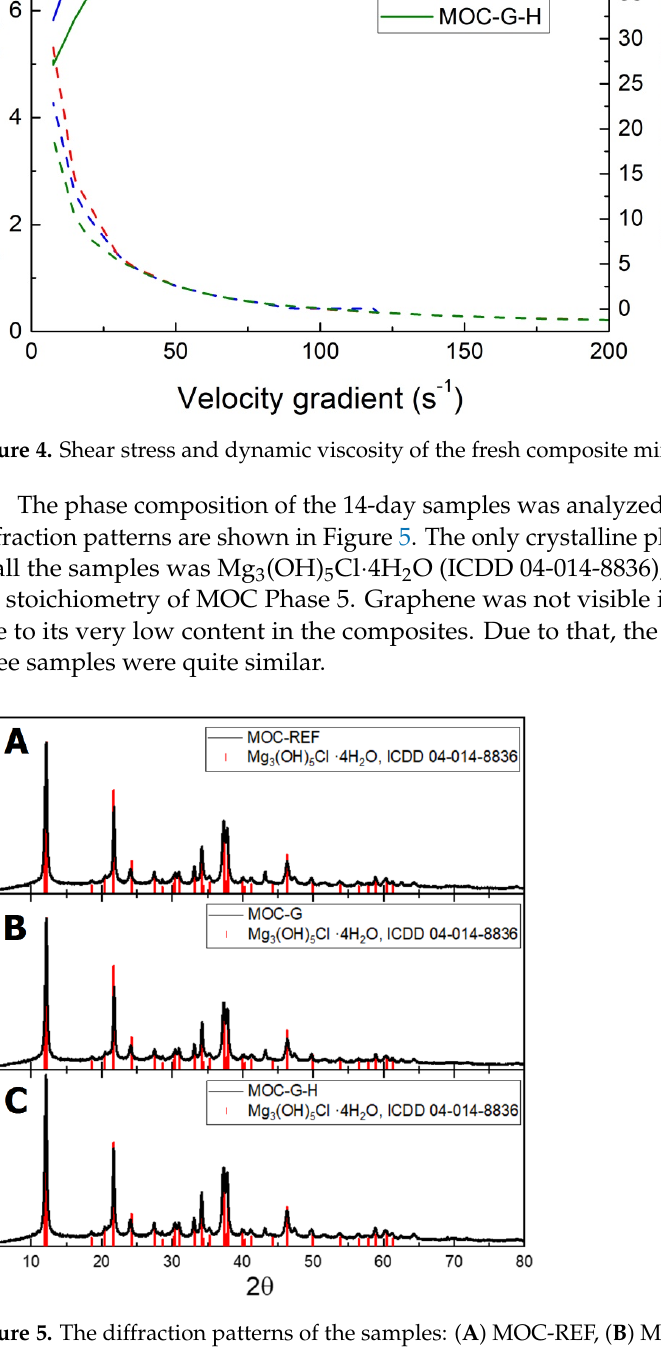
Figure 6. Micrographs of prepared samples: ( A ) MOC-REF, ( B ) MOC-G, and ( C ) MOC-G-H.